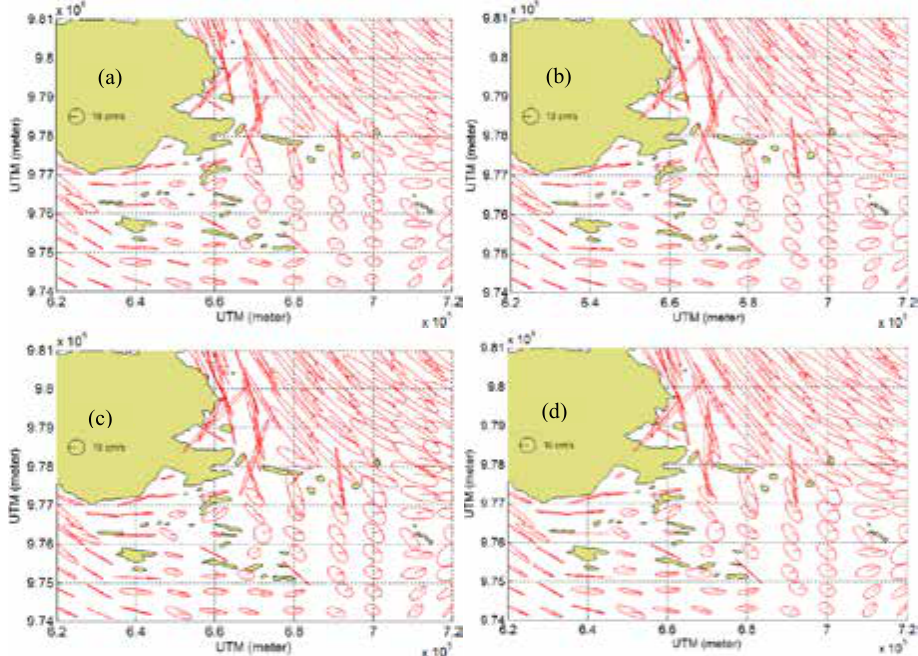
Fig. 9: The calculated M2 tidal current in layer‐1 near the bottom (a), layer‐4 of water column (b), layer‐7 of water column, and layer‐10 at the surface water (d)